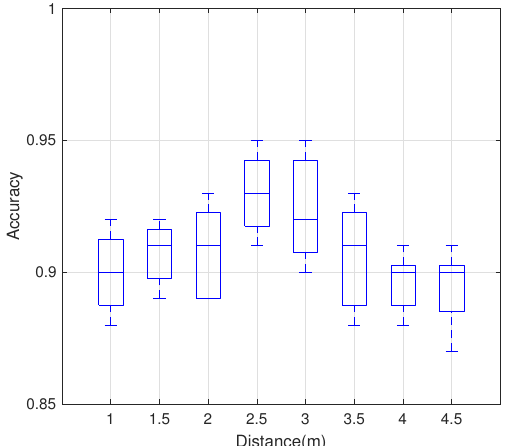
Figure 9. Impact of distance between transmitting and receiving ends on the recognition accuracy.